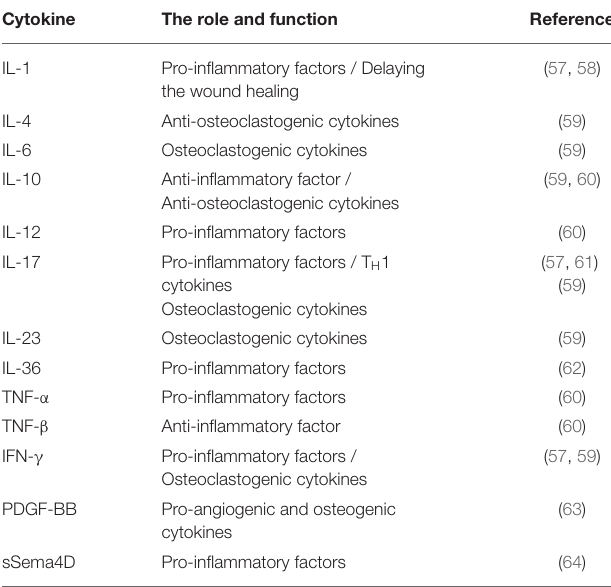
TABLE 1 | The role of various cell cytokines in the development of MRONJ.